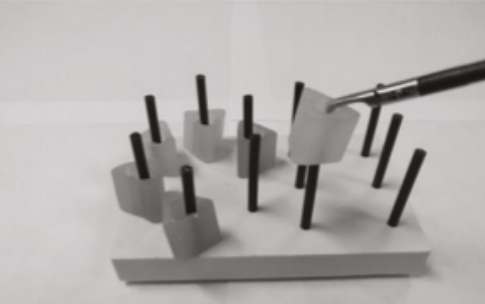
Figure 6: Left and right shift of six rubber triangles.